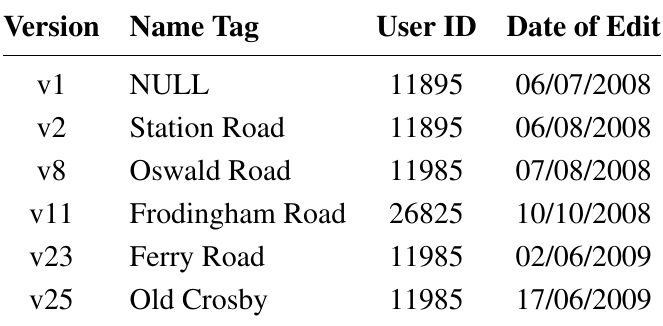
Table 3. An example of the “name” tag changing on a street polyline in the